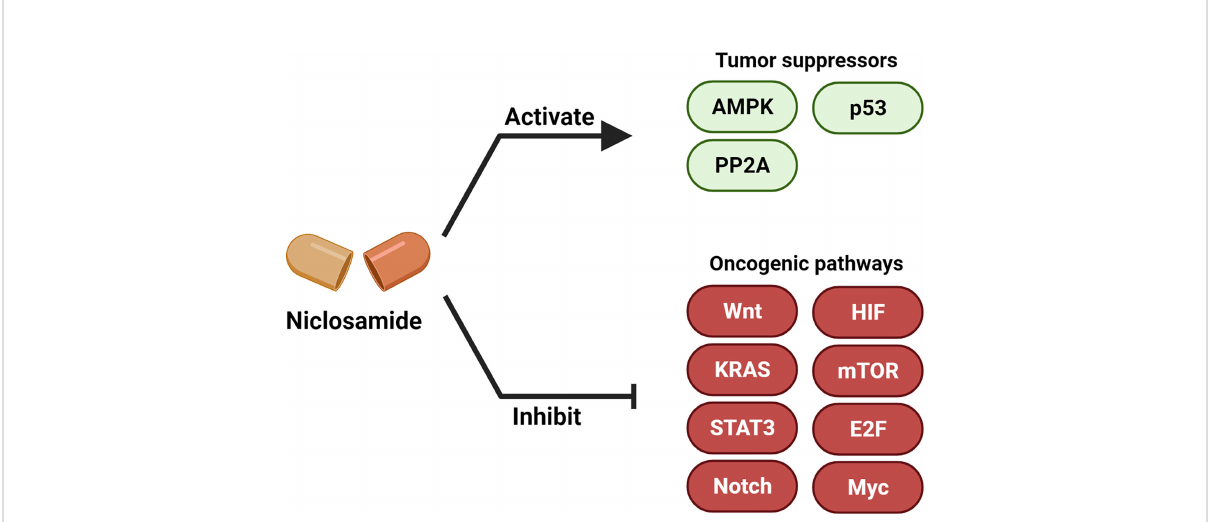
FIGURE 3 Niclosamide activates tumor suppressors and inhibits oncogenic pathways. Niclosamide has anti-tumor effect through inhibiting multiple oncogenic pathways such as Wnt/ b -catenin, Ras, Stat3, Notch, E2F-Myc, NF- k B and mTOR, and activating tumor suppressor signaling such as p53, PP2A and AMPK. Created with